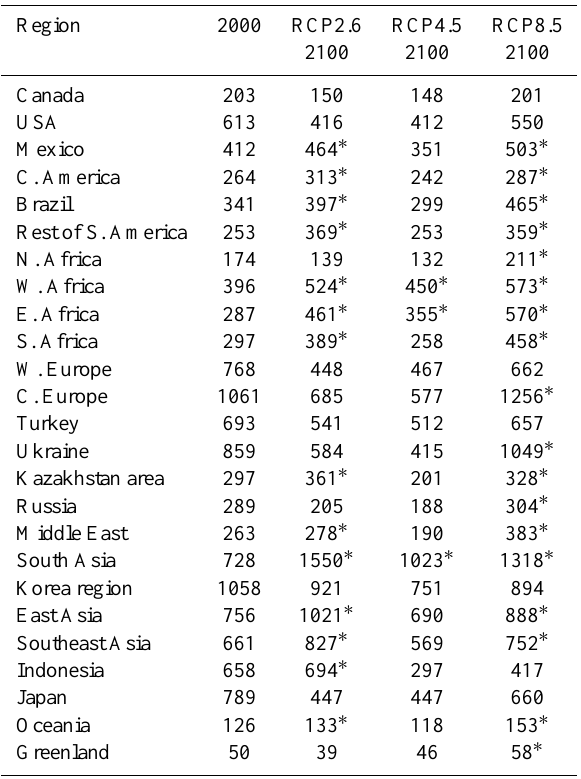
Table 7. Average MMM nitrogen (NH x + NO y ) deposition (mg(N)m − 2 yr − 1 ) over specific regions as defined in Lamarque et al. (2011).